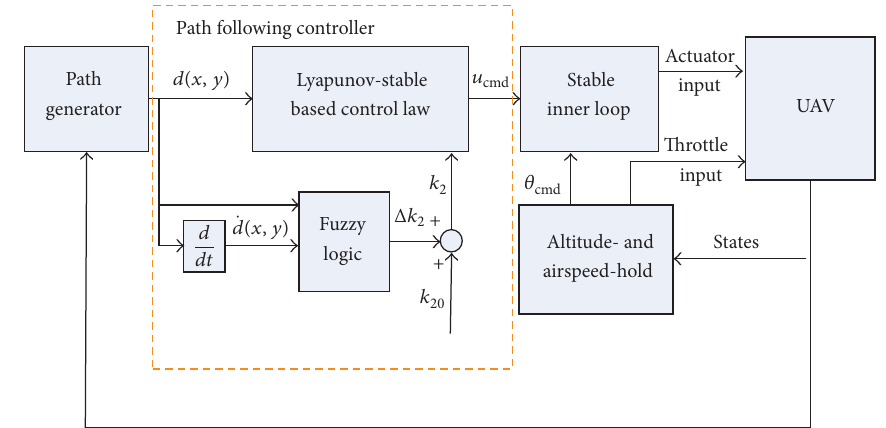
Figure 3: The structure of the proposed controller.